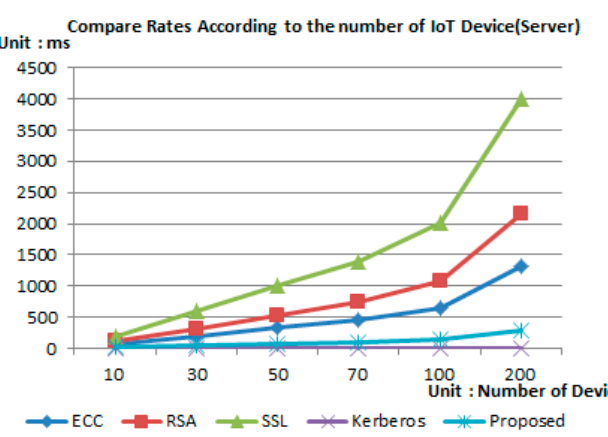
Figure 8. Analysis of authentication time—server.